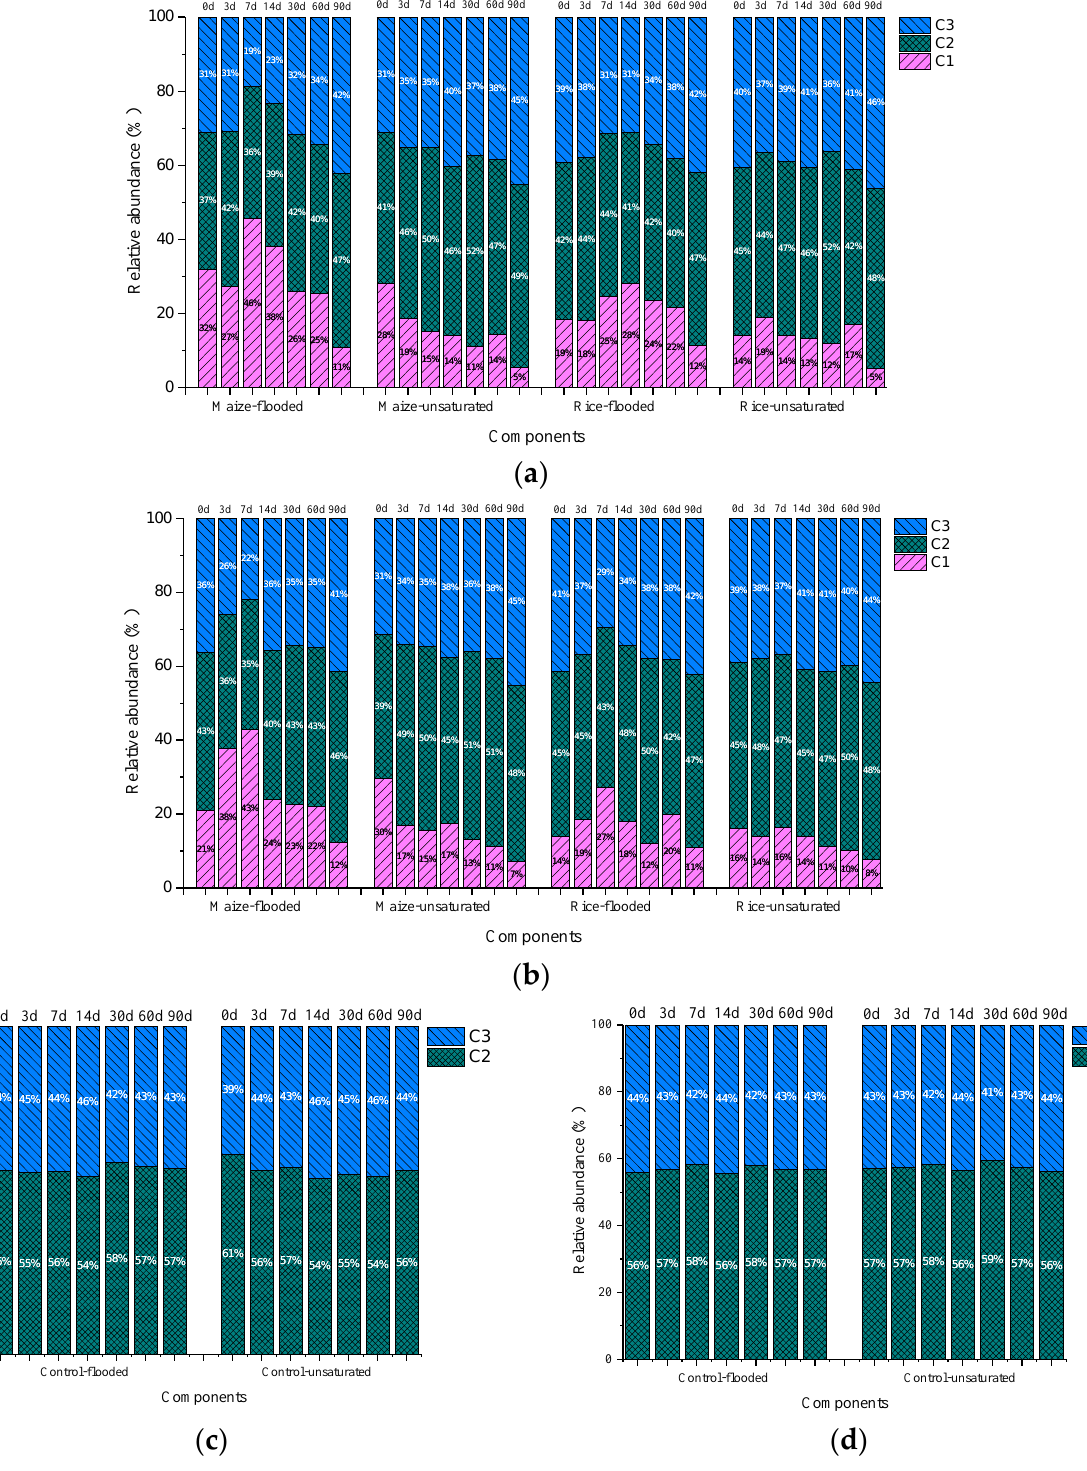
Figure 4. Temporal changes of relative abundances of fluorescent DOM components in the soils under different treatments during laboratory incubation: straw amended soil of site A ( a ); straw amended soil of site B ( b ); control soil of site A ( c ); control soil of site B ( d ).